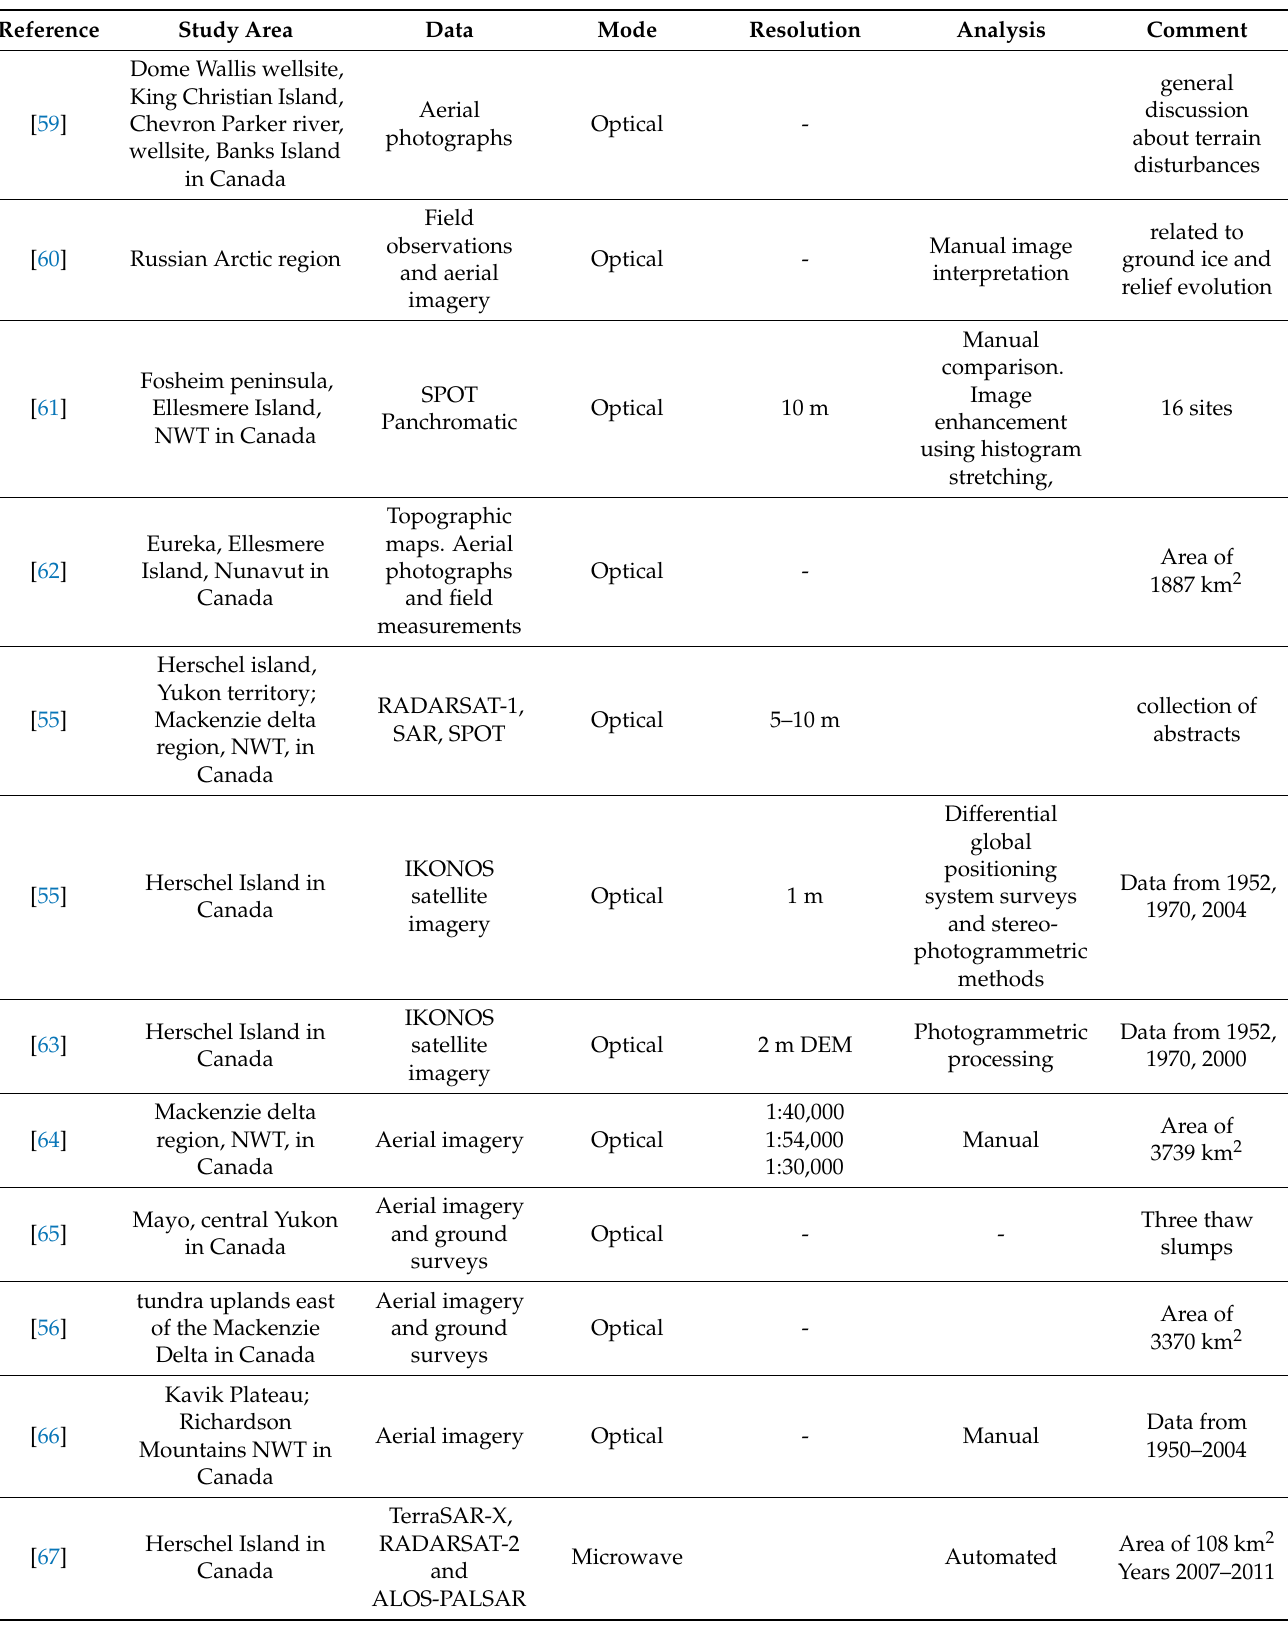
Table 2. A selected list of literature related to retrogressive thaw slump mapping using remote sensing